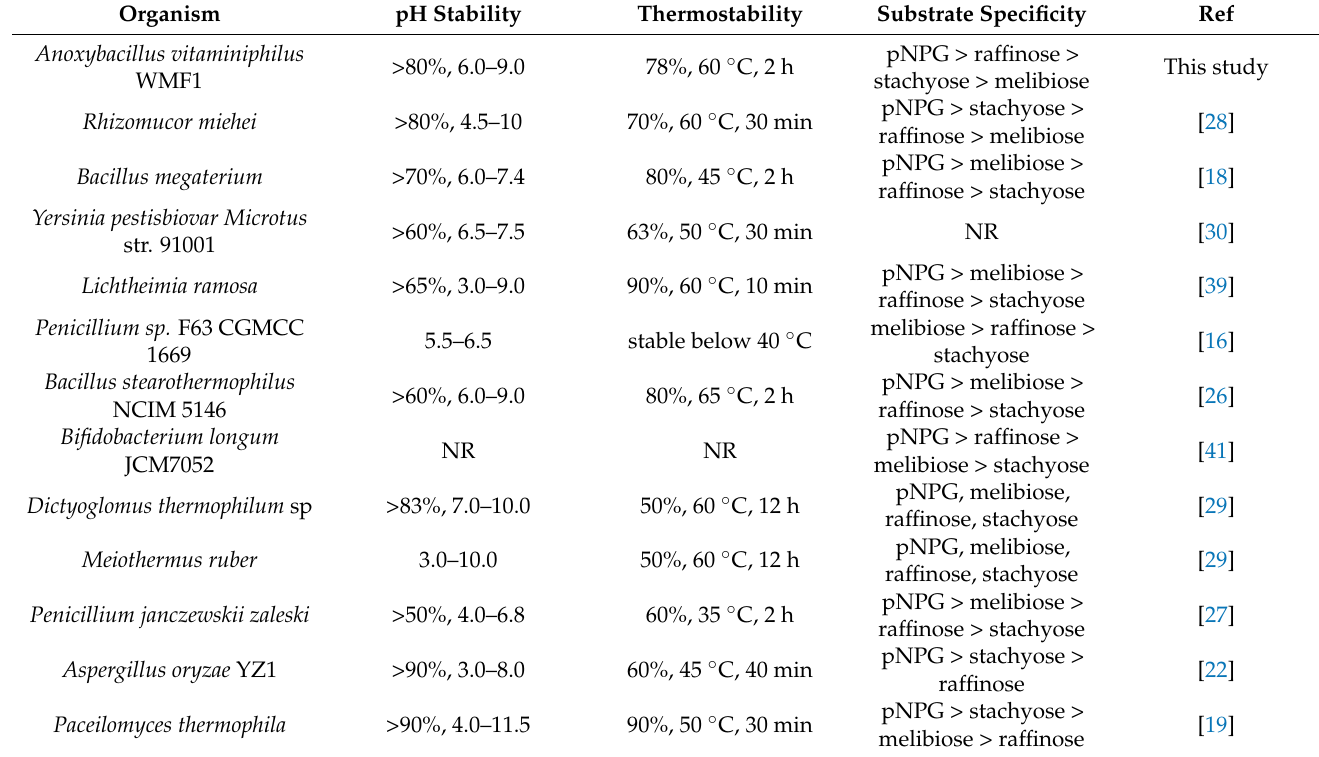
Table 3. Thermal and pH stability and substrate specificity of GH36 family α